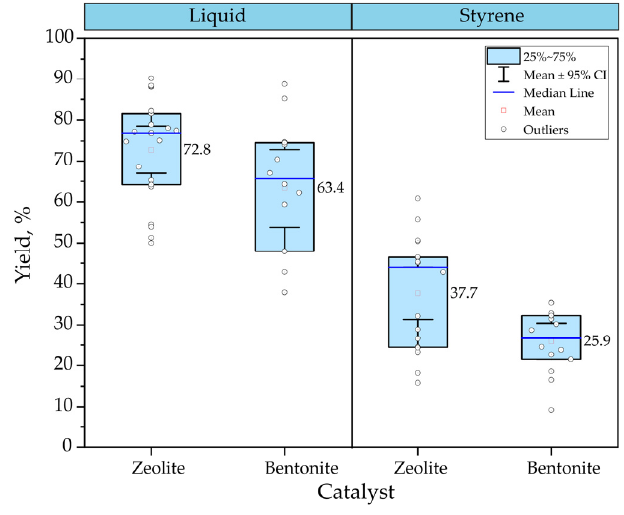
Figure 8. Comparison between zeolite and bentonite in the catalytic pyrolysis of PS.